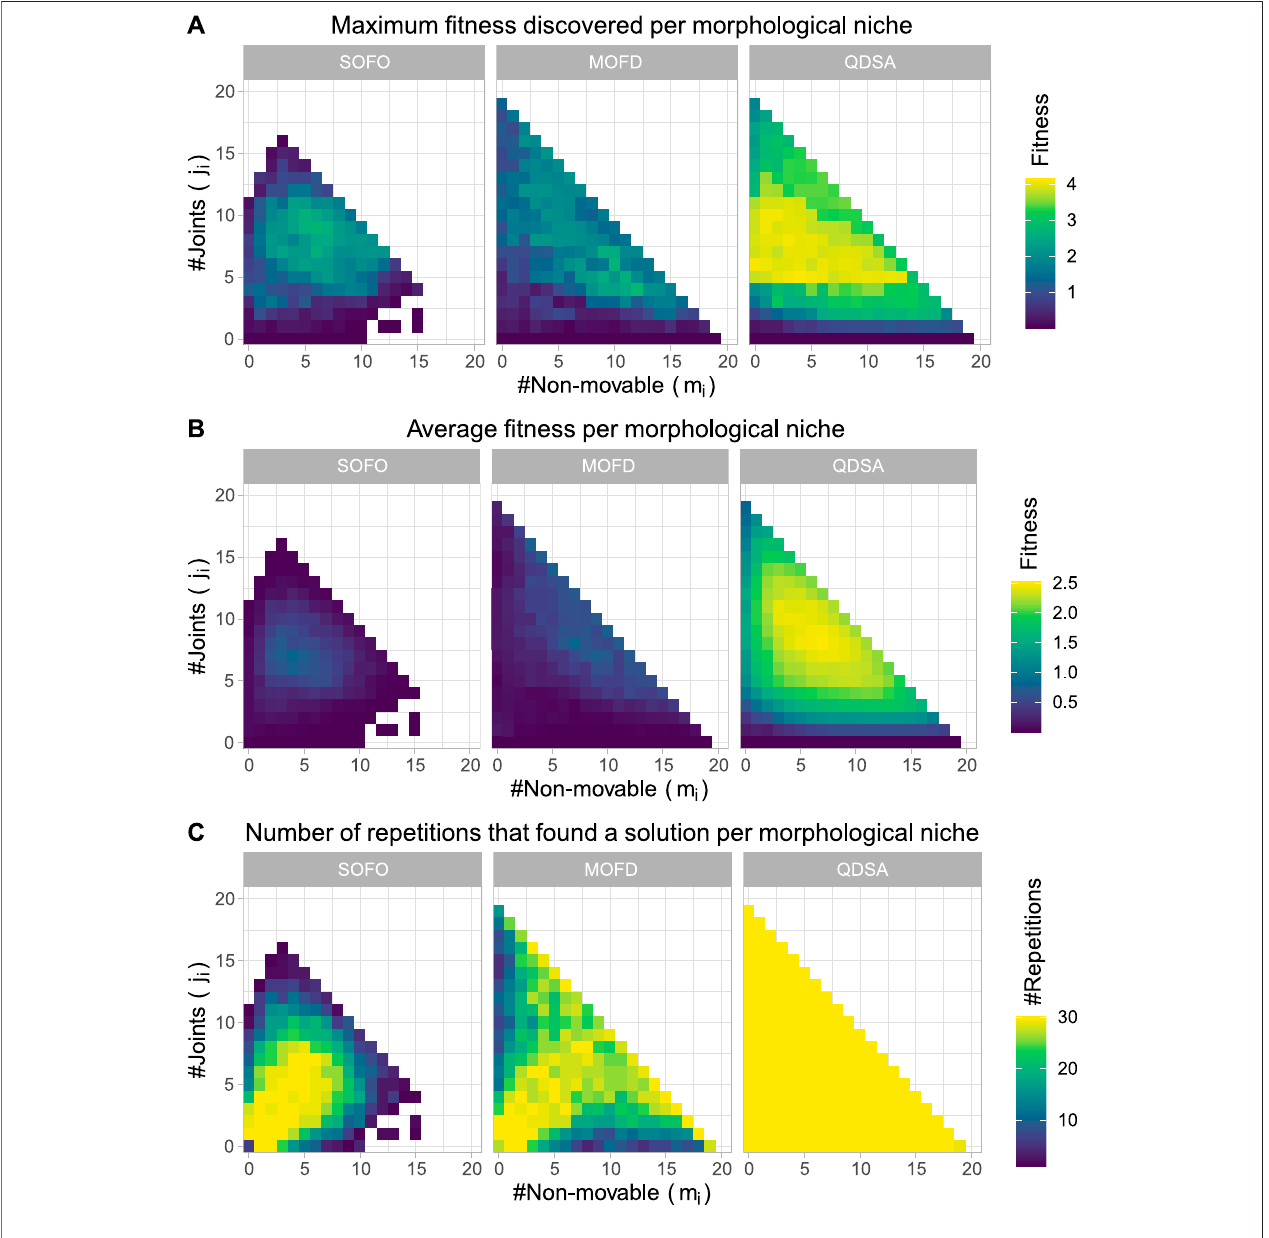
FIGURE 5 | The fi gures show properties of the population for each search algorithm over all 30 runs. (A) shows maximum fi tness of morphological niches, where the color represents fi tness. (B) shows the average fi tness, where for each niche the color is the average fi tness calculated over the 30 runs. (C) shows the number of repetitions that found a solution for the given